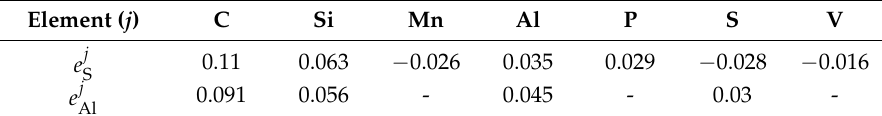
Table 9. Activity interaction coefficients in molten